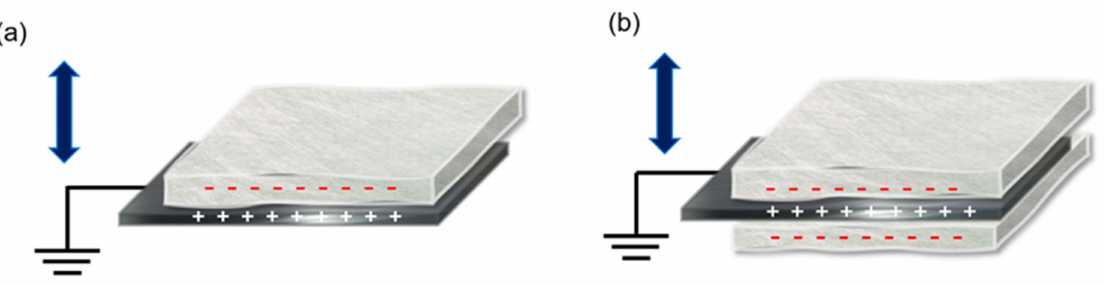
Figure 1. Working principle of ( a ) original FTENG and ( b ) electrode insertion type FTENG. (+: positive charge, − : negative